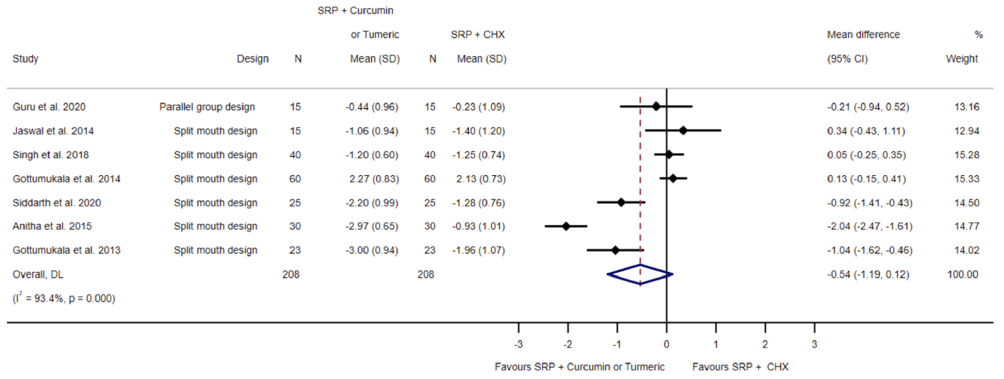
Figure 6. Forest plot for the comparison of SRP and chlorhexidine to SRP and local curcumin/tur- meric application related to probing pocket depth reduction [47–53]. application related to probing pocket depth reduction